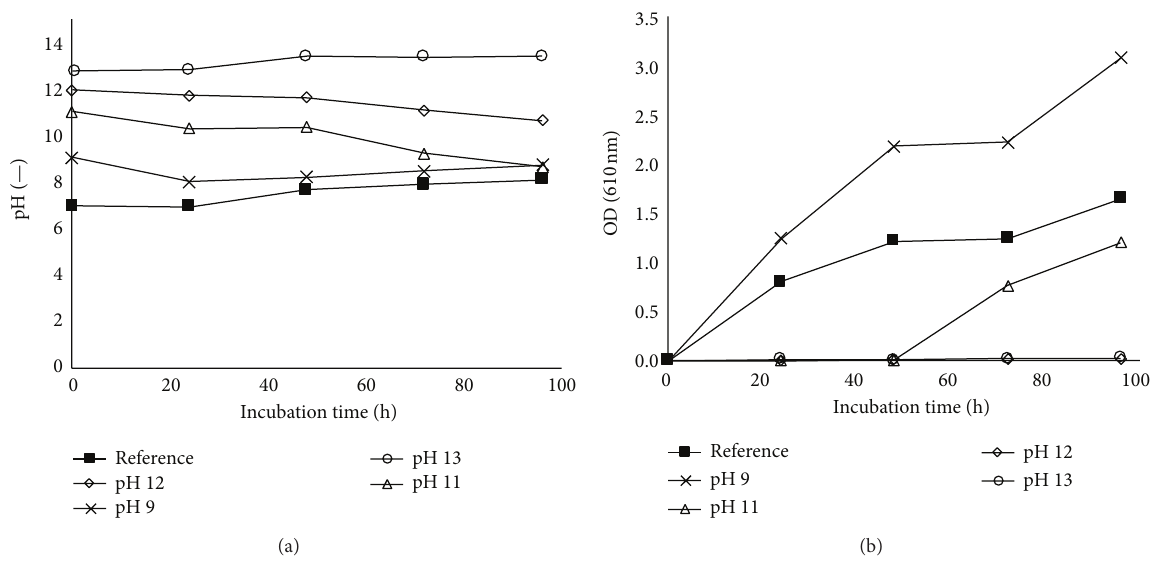
Figure 6: Evolution of pH (a) and OD (b) during the growth of Bacillus mucilaginosus in nutrient broth medium with different initial pH values.